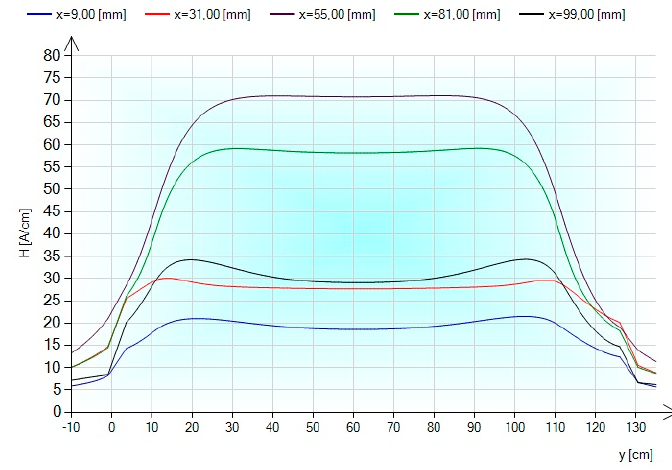
Figure 15. The distribution of magnetic field intensity of a shielded busbar system for y = var and di ff erent values of x = const in the case of current symmetry.